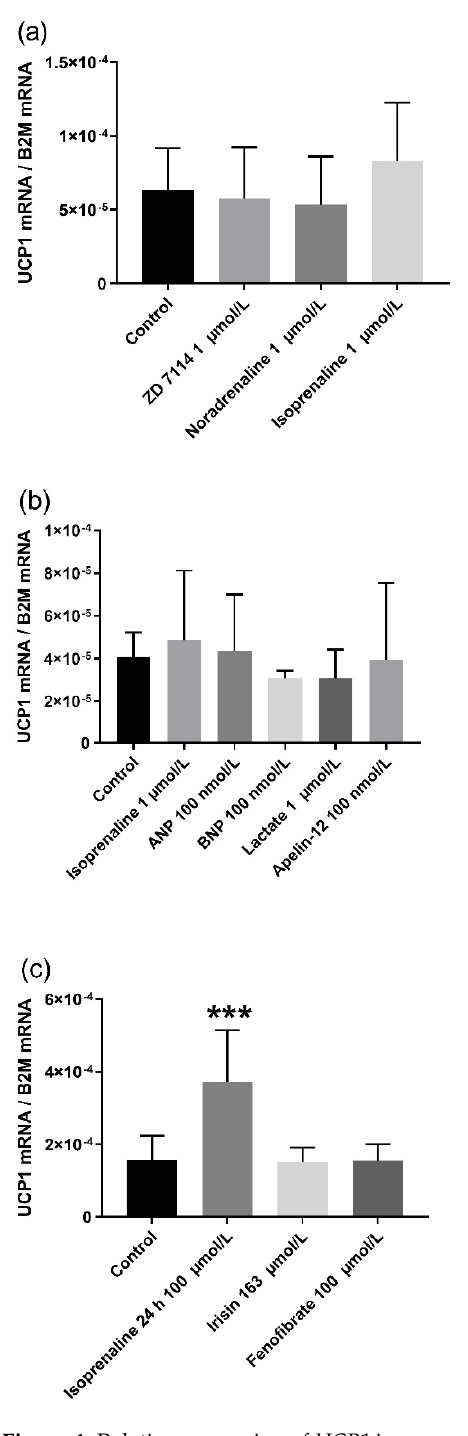
Figure 4. Relative expression of UCP1 in raccoon dog adipocytes treated for 7 days with ( a ) 1 µ mol/L ZD 7114 hydrochloride (ZD 7114), 1 µ mol/L noradrenaline, and 1 µ mol/L isoprenaline ( n = 4). ( b ) 100 nmol/L ANP, 100 nmol/L BNP, 1 µ mol/L lactate, and 100 nmol/L apelin-12 ( n = 4). ( c ) Acute 24 h 100 µ mol/L isoprenaline as positive control, 163 µ mol/L irisin, and 100 µ mol/L fenofibrate ( n = 8). Control adipocytes were treated with PBS. UCP1 expressions are normalized to the expression of B2M and the result values are presented as mean ± SD. Statistically significant difference is indicated by *** p ≤